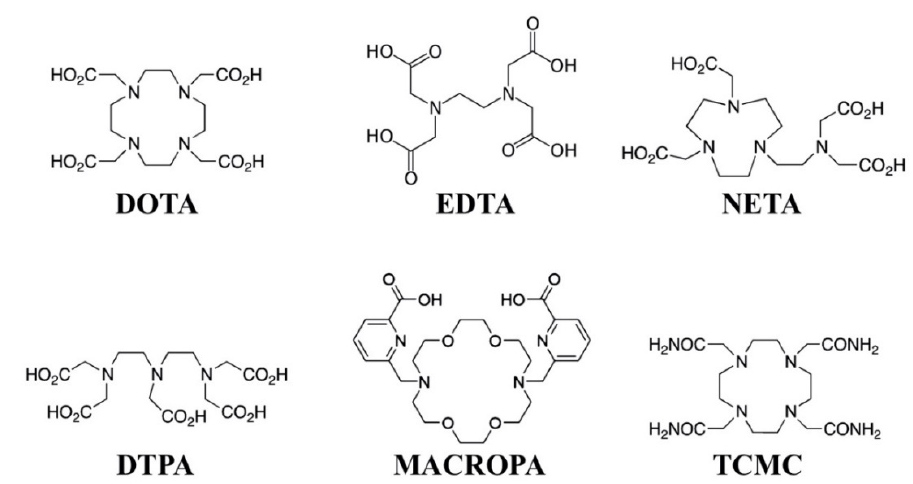
Figure 3. Several commonly employed radiometal chelators. Table 4. Chelators for therapeutic α emitters.